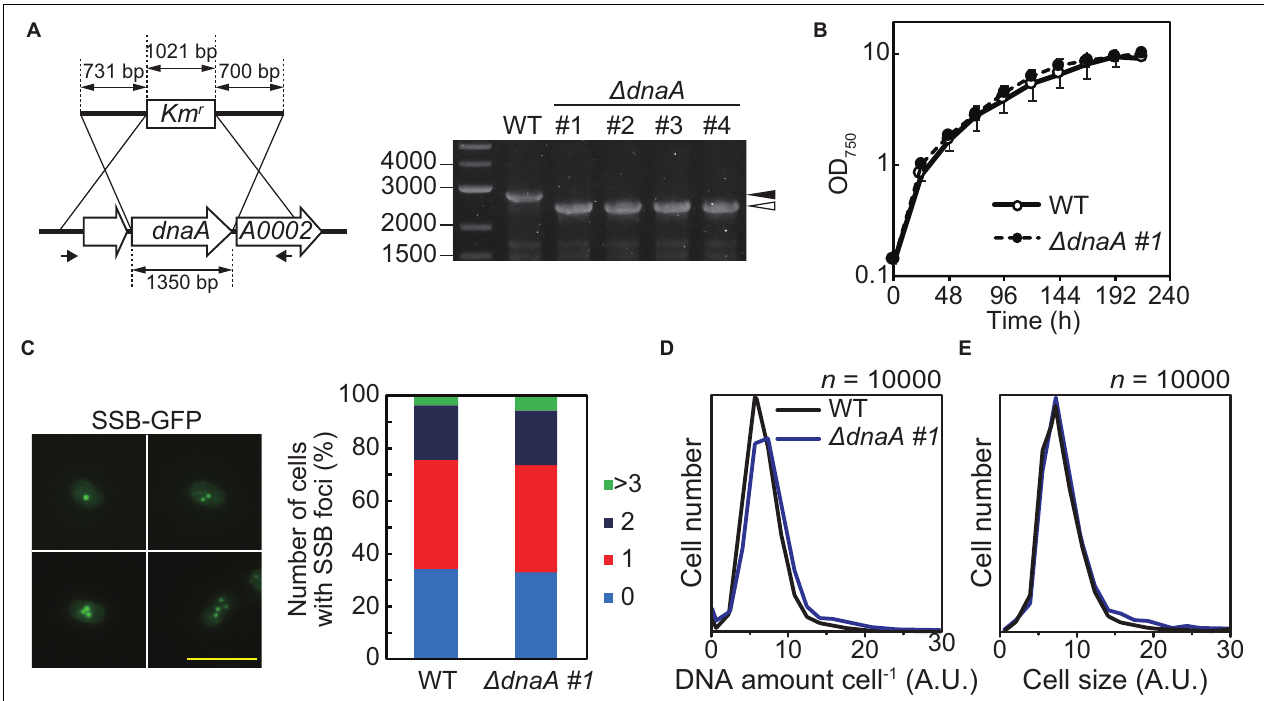
FIGURE 4 | Effect of deleting dnaA on the growth and DNA replication of Synechococcus sp. PCC 7002. (A) Chromosomal dnaA was replaced with the gene encoding kanamycin resistance ( Km r ) through homologous recombination. Insertion of Km r into the chromosomal dnaA locus was confirmed using PCR with the primers indicated by the arrows. The wild type (WT) was used as a negative control. The black and white arrowheads indicate the bands amplified from the WT and mutated chromosomes, respectively. The four independent colonies of the dnaA -deficient mutant were analyzed. (B) Growth of WT and (cid:49) dnaA clone #1 in an inorganic medium with illumination (70 µ mol m − 2 s − 1 ). Other (cid:49) dnaA clones (#2–#4) are shown in Supplementary Figure S6B . (C) Frequencies of cells exhibiting zero (blue), one (red), two (deep blue), or > 3 (green) SSB-GFP foci in WT and (cid:49) dnaA clone #1 cultures 12 h after inoculation ( n > 300 cells, each strain). For reference, a representative fluorescence image of WT expressing SSB-GFP (green fluorescence) is shown (one to four SSB-GFP foci are shown). Scale bar = 5 µ m. The construction of SSB-GFP expresser is described in Supplementary Figure S3 . (D,E) Flow cytometric analysis showing the distributions of the DNA level per cell (D) and the cell volumes (E) of cultures of the WT (black line) and (cid:49) dnaA clone #1 (blue line) 12 h after inoculation, respectively. DNA was stained with SYTOX Green, and the levels were determined according to the intensity of the green